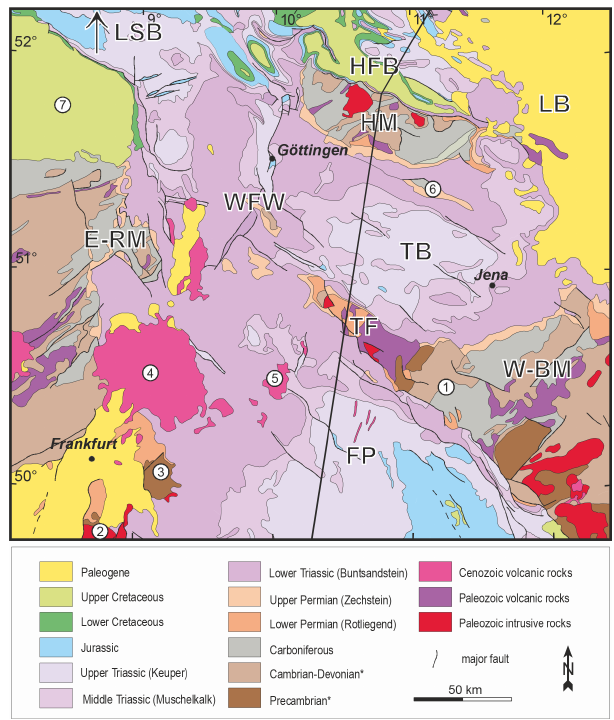
Figure 3. Geological map of the study area (simplified after Bun- desanstalt für Geowissenschaften und Rohstoffe, 2004; ∗ affected by a variable degree of metamorphic overprint). Abbreviations are used for geological–structural units mentioned in the text and corre- spond to the stratigraphical columns in Fig. 5a: LSB – Lower Sax- ony Basin, HFB – Harz Foreland Basin, HM – Harz Mountains, LB – Leipzig Basin, TB – Thuringian Basin, TF – Thuringian Forest, WFW – Werra–Fulda–Weser region, E-RM – eastern Rhenish Mas- sif, FP – Franconian platform, W-BM – western Bohemian Mas- sif. Locations of further geographical–geological units mentioned in the text are labelled with numbers: (1) Thuringian Schiefer- gebirge, (2) Odenwald, (3) Spessart, (4) Vogelsberg, (5) Rhön, (6) Kyffhäuser High, (7) Münsterland Basin. The black line indi- cates the trace of the section shown in Fig.